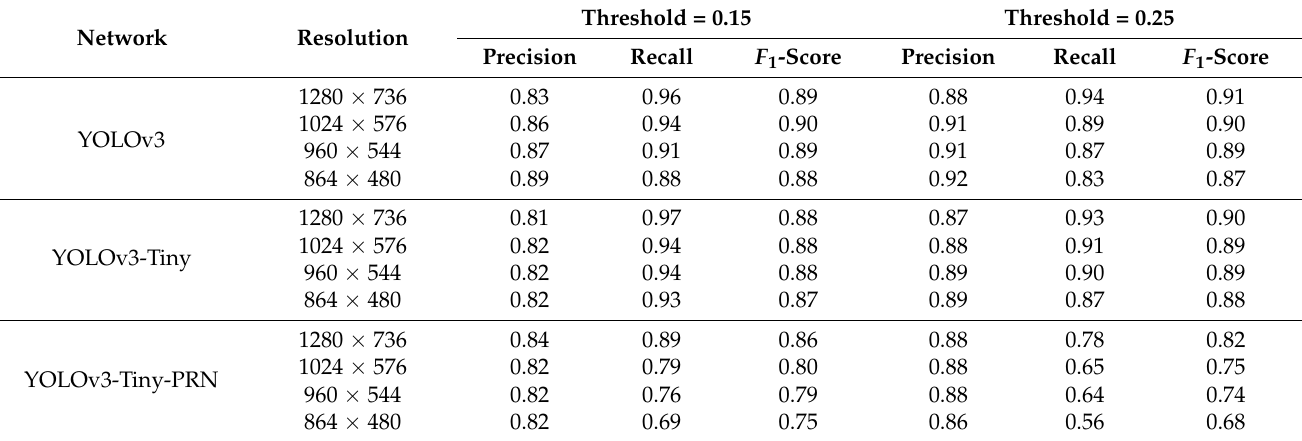
Similar to hair fescue, detection of at least one sheep sorrel plant produced greatly improved results compared to detection of all sheep sorrel plants (Table 4). Lowering the detection threshold yielded variable results on the F 1 -scores. YOLOv3-Tiny-PRN improved at all four resolutions by an average of 0.06 while YOLOv3-Tiny performed better by an average of 0.01 at the original 0.25 threshold. The F 1 -score for YOLOv3 showed no change at the two middle resolutions, increased by 0.01 at 864 × 480, and decreased by 0.02 at 1280 × 736. The peak F 1 -score (0.91) was achieved with YOLOv3 at 1280 × 736 and a threshold of 0.25, while the minimum F 1 -score (0.68) was produced with YOLOv3-Tiny- PRN at 860 × 480 and a threshold of 0.25. All three networks except YOLOv3-Tiny-PRN at the three lowest resolutions had F 1 -scores of 0.87 or higher at both thresholds. Table 4. Results for correct detection of at least one sheep sorrel plant per image in the validation dataset. Threshold = 0.15 Threshold = 0.25 Network Resolution Precision Recall F 1 -Score Precision Recall F 1 -Score 0.94